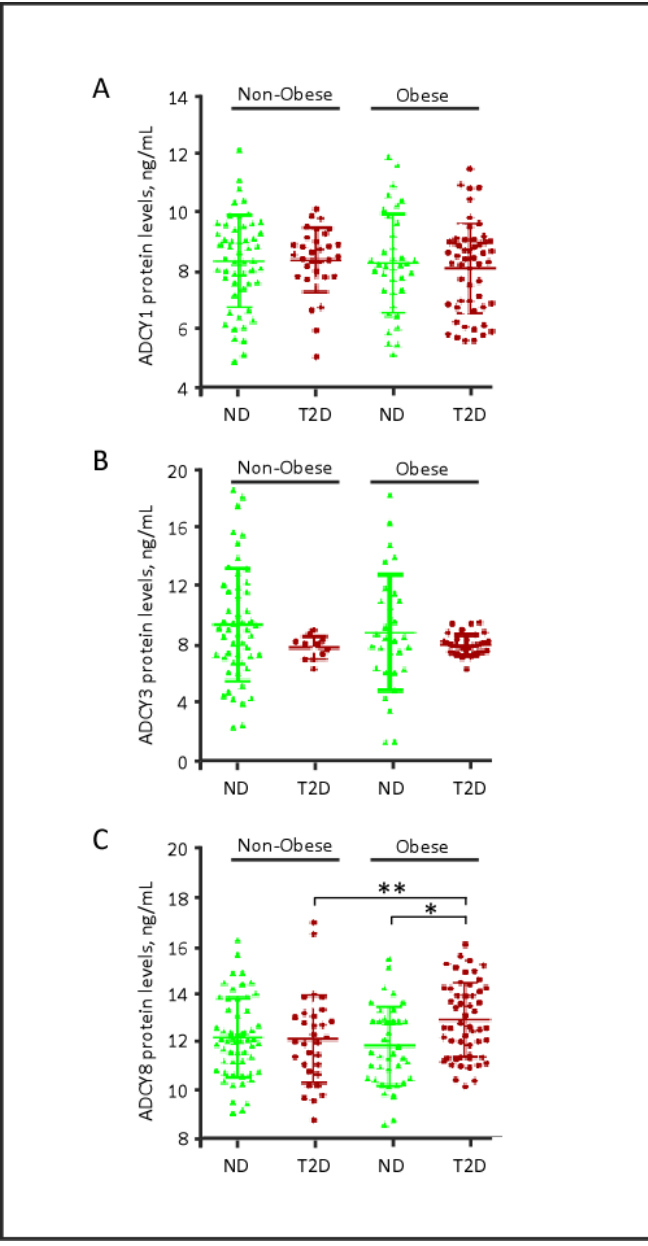
Figure 2. Quantitative analysis of ADCY1, ADCY3 and ADCY8 based on diabetes and obesity status. * p = 0.001, ** p = 0.039. The statistical tests are Mann Whitney U test for ADCY3 ( B ) and unequal variance t-test for ADCY1 ( A ) and ADCY8 ( C ). ND, non-diabetic; T2D, type 2 diabetes.